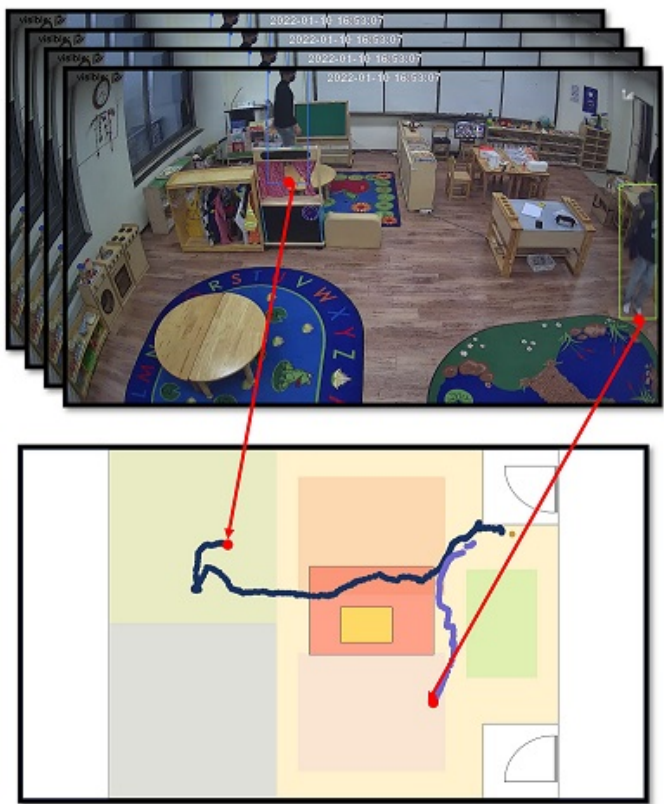
Figure 3. Local tracklet represented in the projection map (bird’s eye